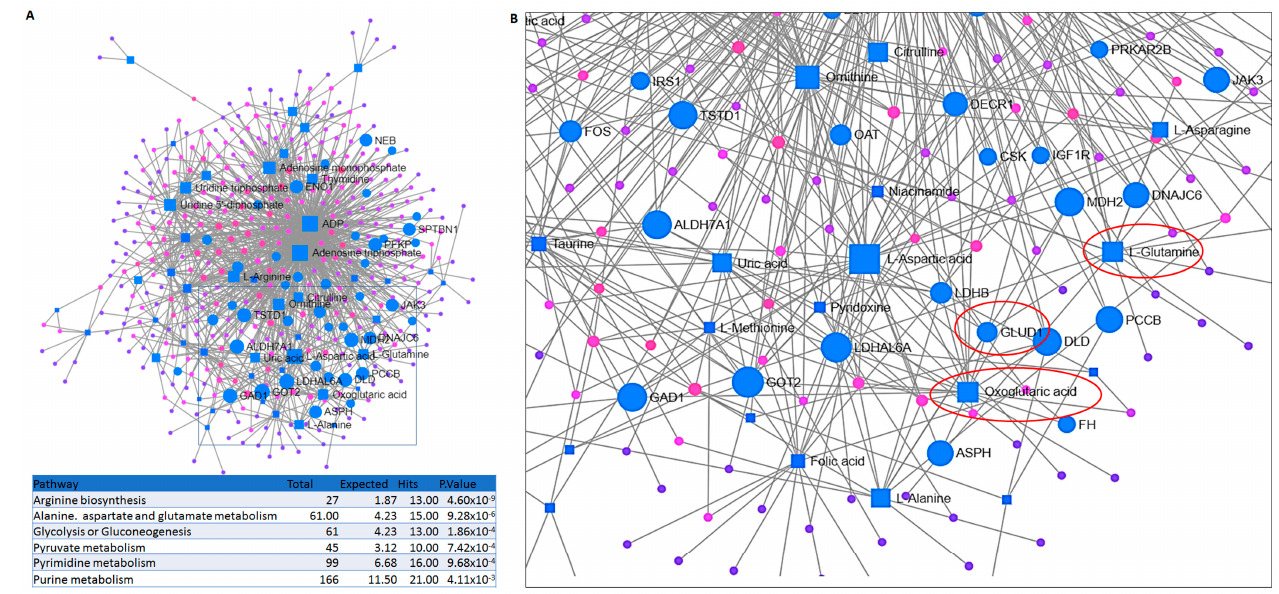
Figure 2. Integrated transcriptomic and metabolomic analysis reveals alterations in the number of biosynthesis pathways. ( A ) Network analysis of differentially expressed genes and metabolites in Sup-PR compared to Sup-B15 cells and statistical data for six of the top ten enriched KEGG pathways. The genes highlighted in blue colour (circles) and metabolites (squares) on the diagram are from the selected pathways. ( B ) A more detailed view of genes and metabolites involved in glutamine metabolism (in red circles)—GLUD1, L -Glutamine and oxoglutaric acid.